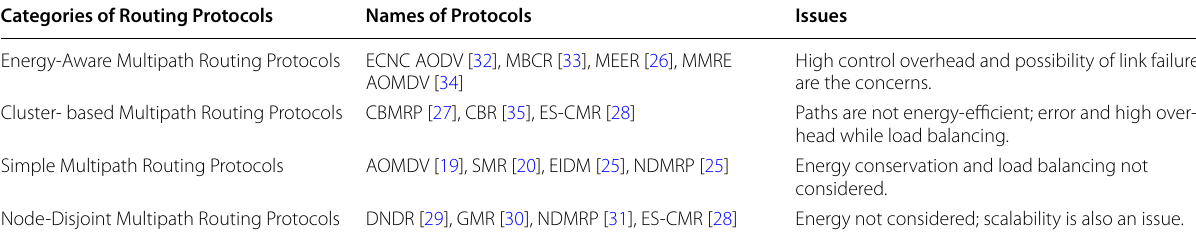
Table 2 Summary of different categories of multipath routing protocols and their issues Categories of Routing